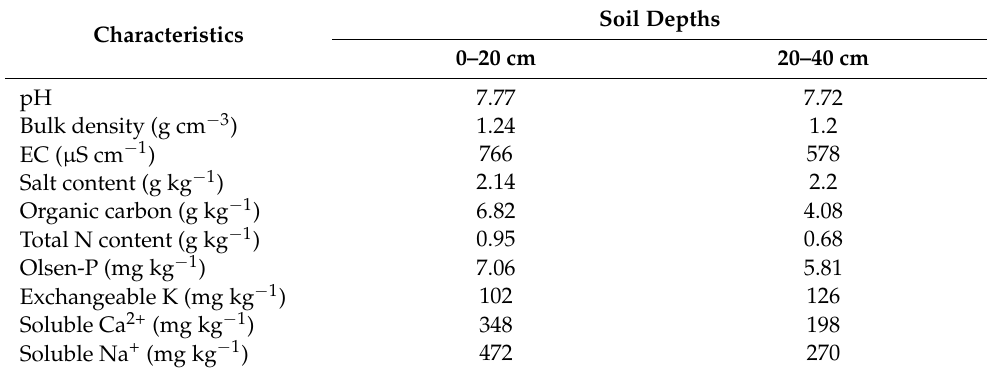
Table 1. Physicochemical properties of the top 0–20 cm and 20–40 cm soil profile in the experiments before field trial sowing in 2017.